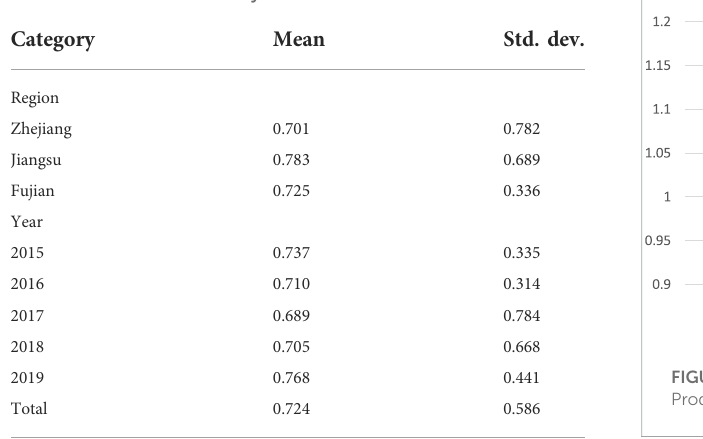
TABLE 2 Production ef fi ciency estimation results.